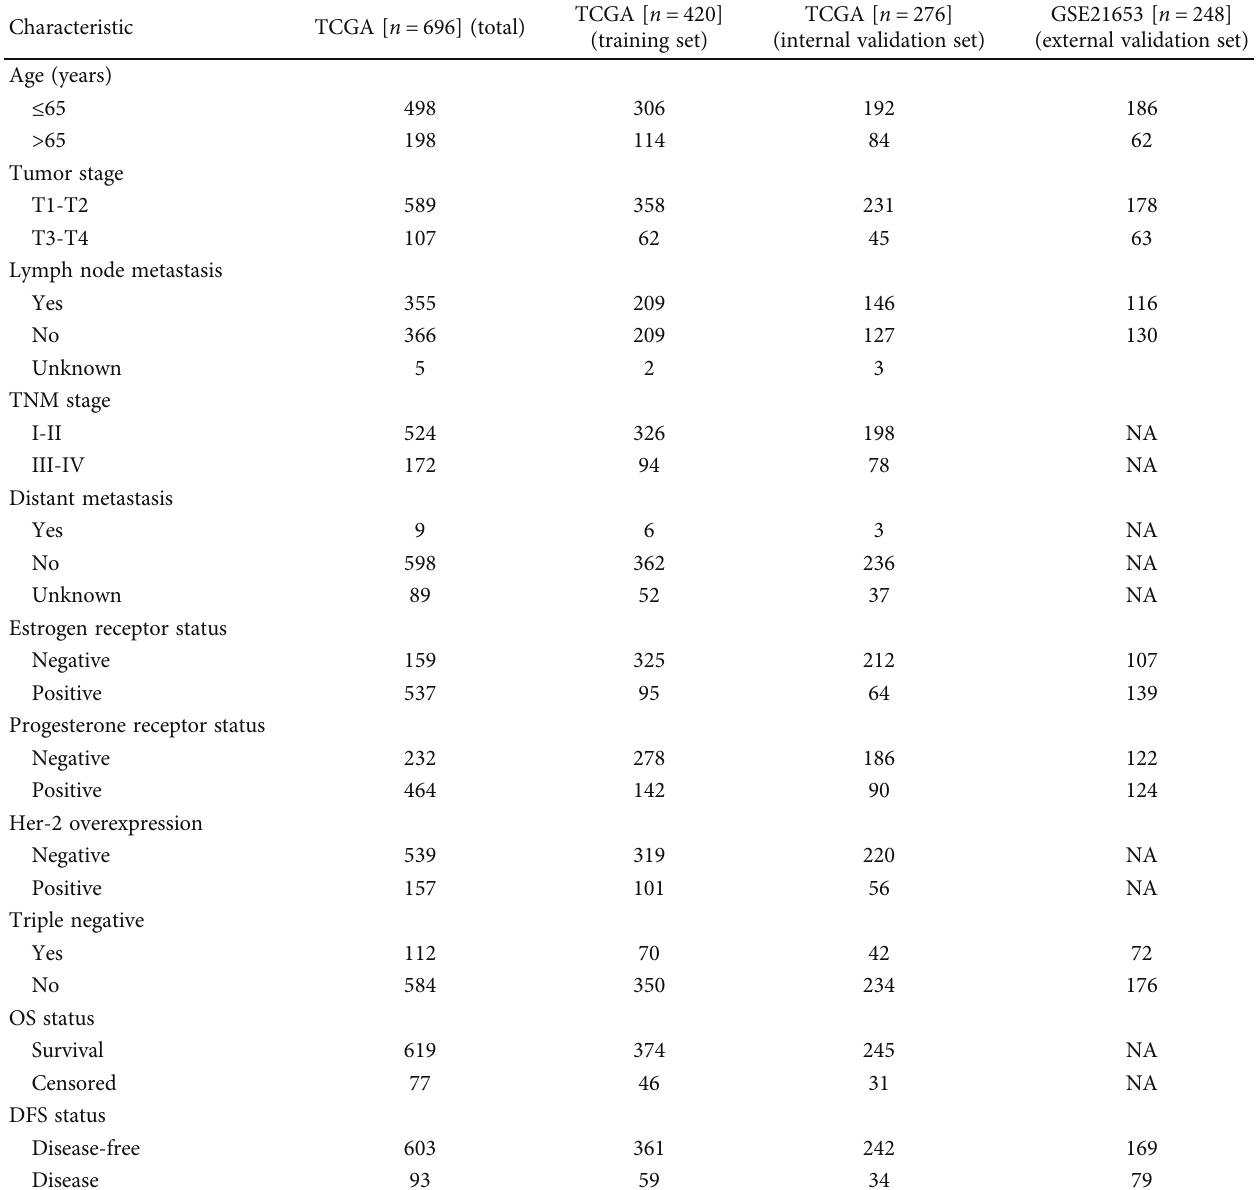
Table 1: Clinical characteristics of the BC patients used in this